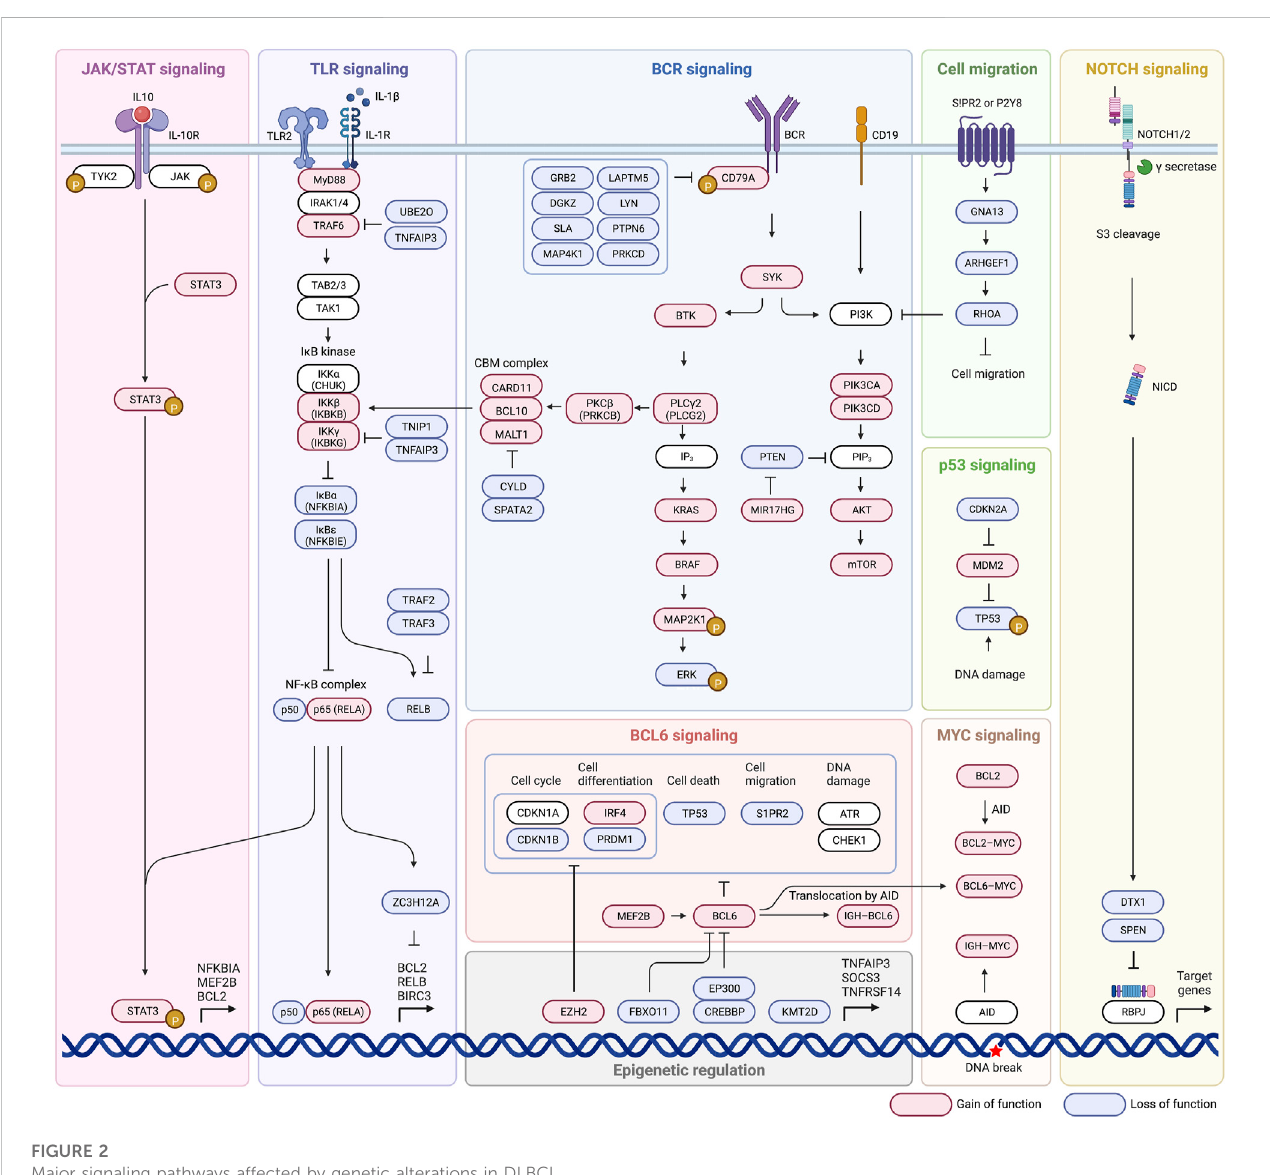
FIGURE 2 Major signaling pathways affected by genetic alterations in